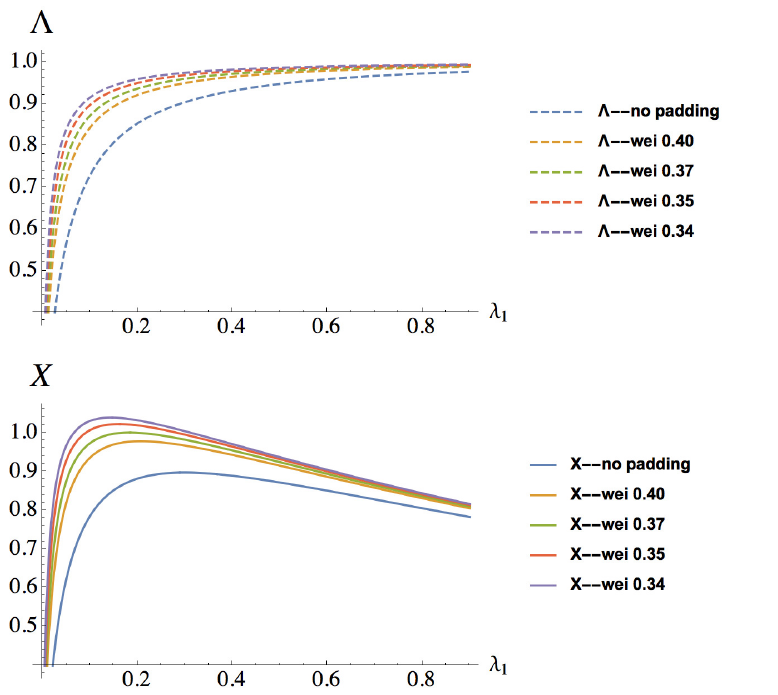
Figure 6. Confidentiality and throughput changing with rekeying rate λ 1 .